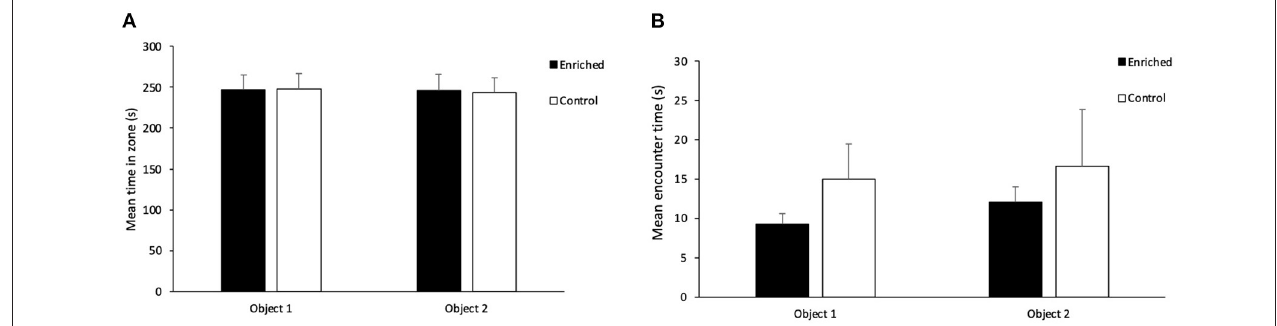
FIGURE 4 | Acquisition Phase on the NOR. (A) Mean time in each object zone for Enriched and Control fish and (B) Mean encounter time for each object for Enriched and Control fish during the acquisition phase of the NOR. Values are displayed as mean ± s.e.m.